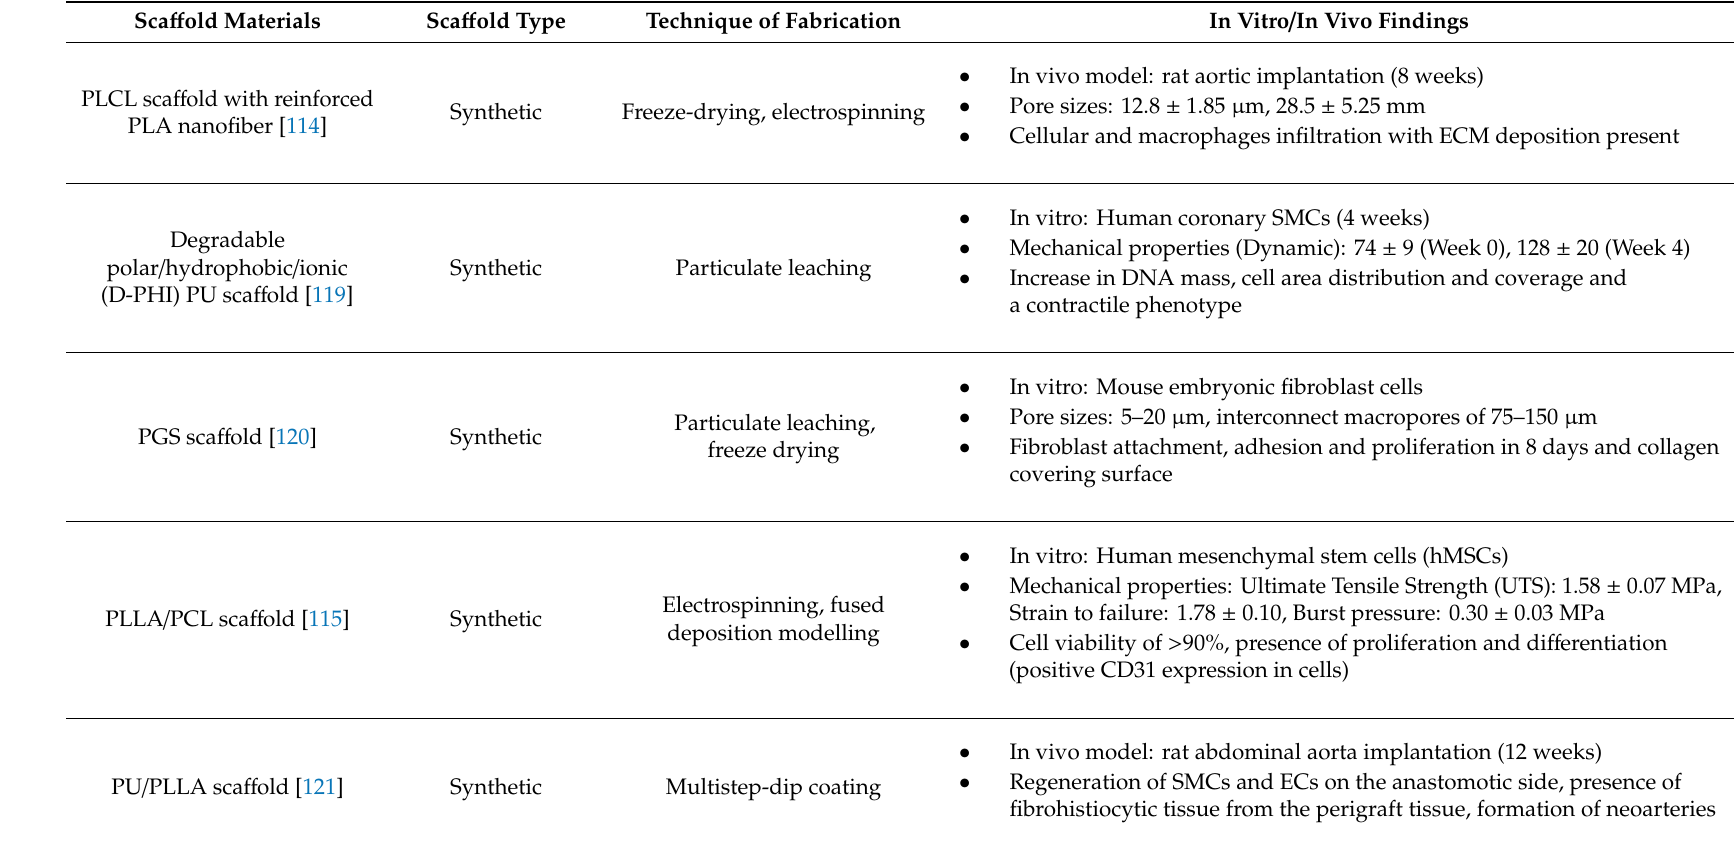
Table 2. Preclinical Studies Involving Synthetic, Natural and Hybrid Vascular Sca ff